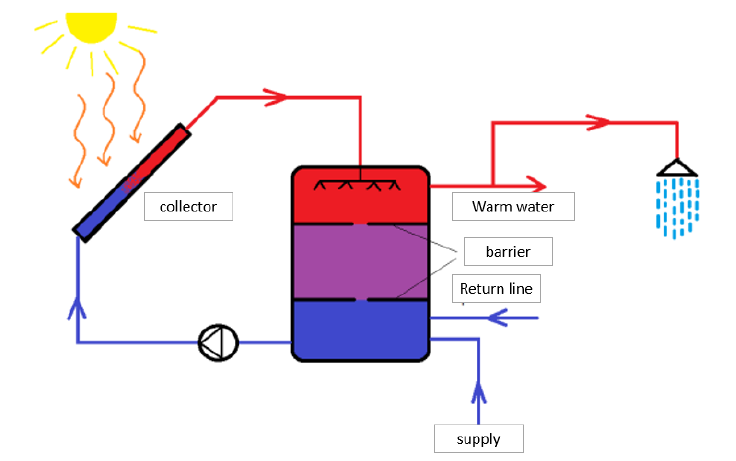
Figure 2. Thermoclective sensor with partitions